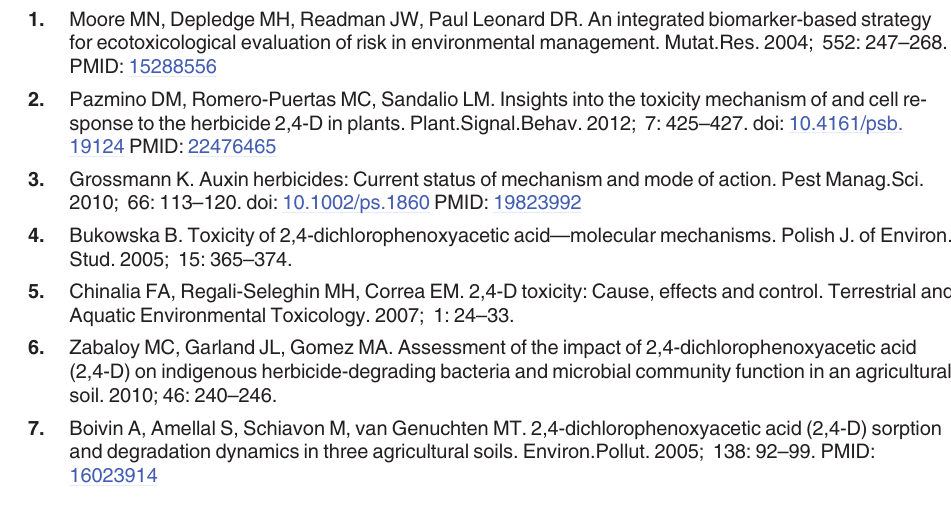
S1 Table. Metabolomics data summary. Pathways altered in Rlv during 2,4-D exposure with associated metabolites, p-value, percentage and their KEGG IDs. For each annotation found in the set, MBRole reports a p-value which describes the probability of identifying a number of metabolites with a particular annotation compared to a random set of the same size within the background set. The percentage values shown for each pathway correspond to the percentage of altered metabolites associated with that pathway compared to the total number of altered metabolites. Metabolites from pathways in bold and regular font had higher and lower levels, respectively, compared to those of formula and control